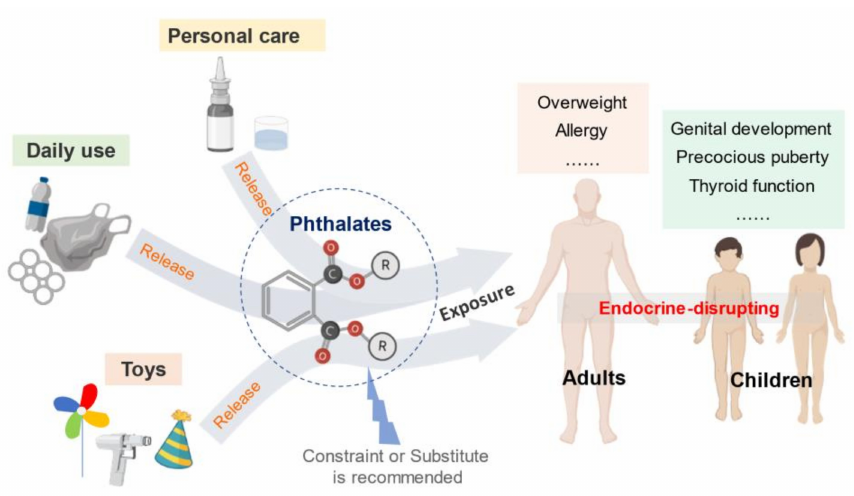
Figure 2. Phthalates application and the impacts on human